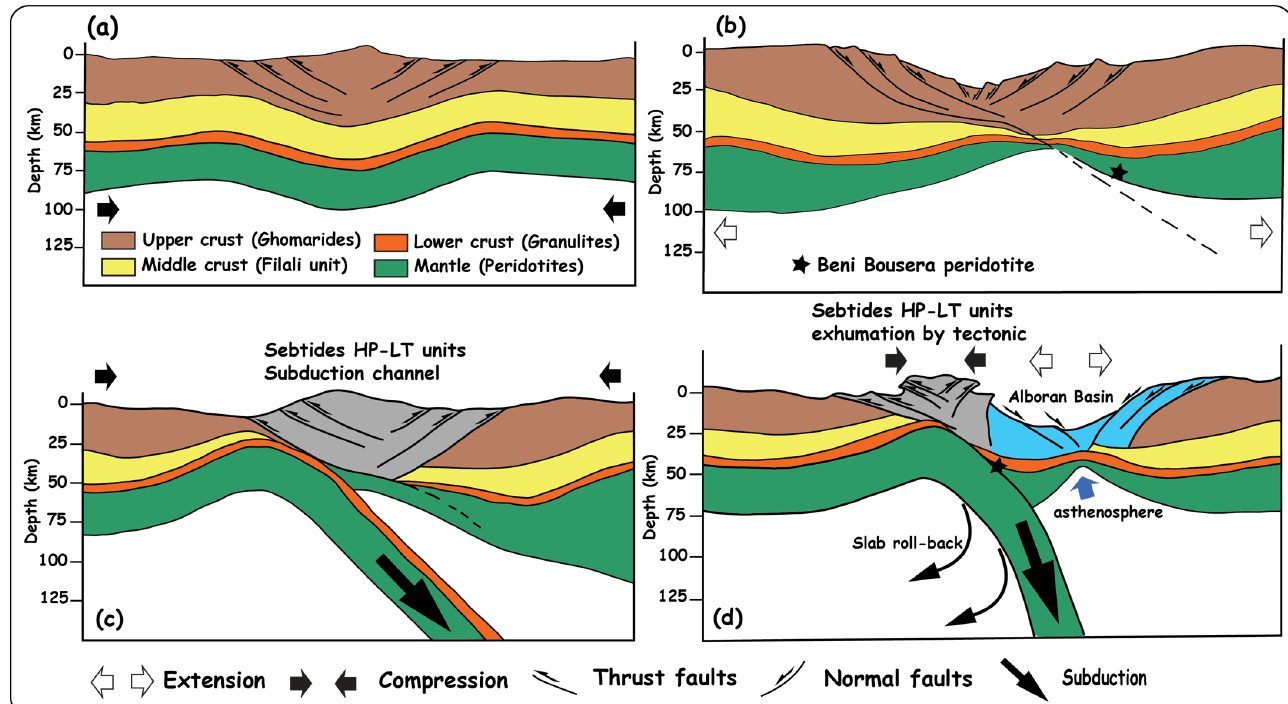
Figure 13. Synthetic geodynamic scenario for the emplacement of the Beni Bousera peridotite and the overlying crustal units of the Alboran domain, based on this study together with previous studies; ( a ) Permo-carboniferous: crustal thickening/shortening; ( b ) Early Jurassic: highly extended crust and upper mantle; ( c ) Upper Eocene–Oligocene; ( d ) Upper Oligocene–Early Miocene. See text for more